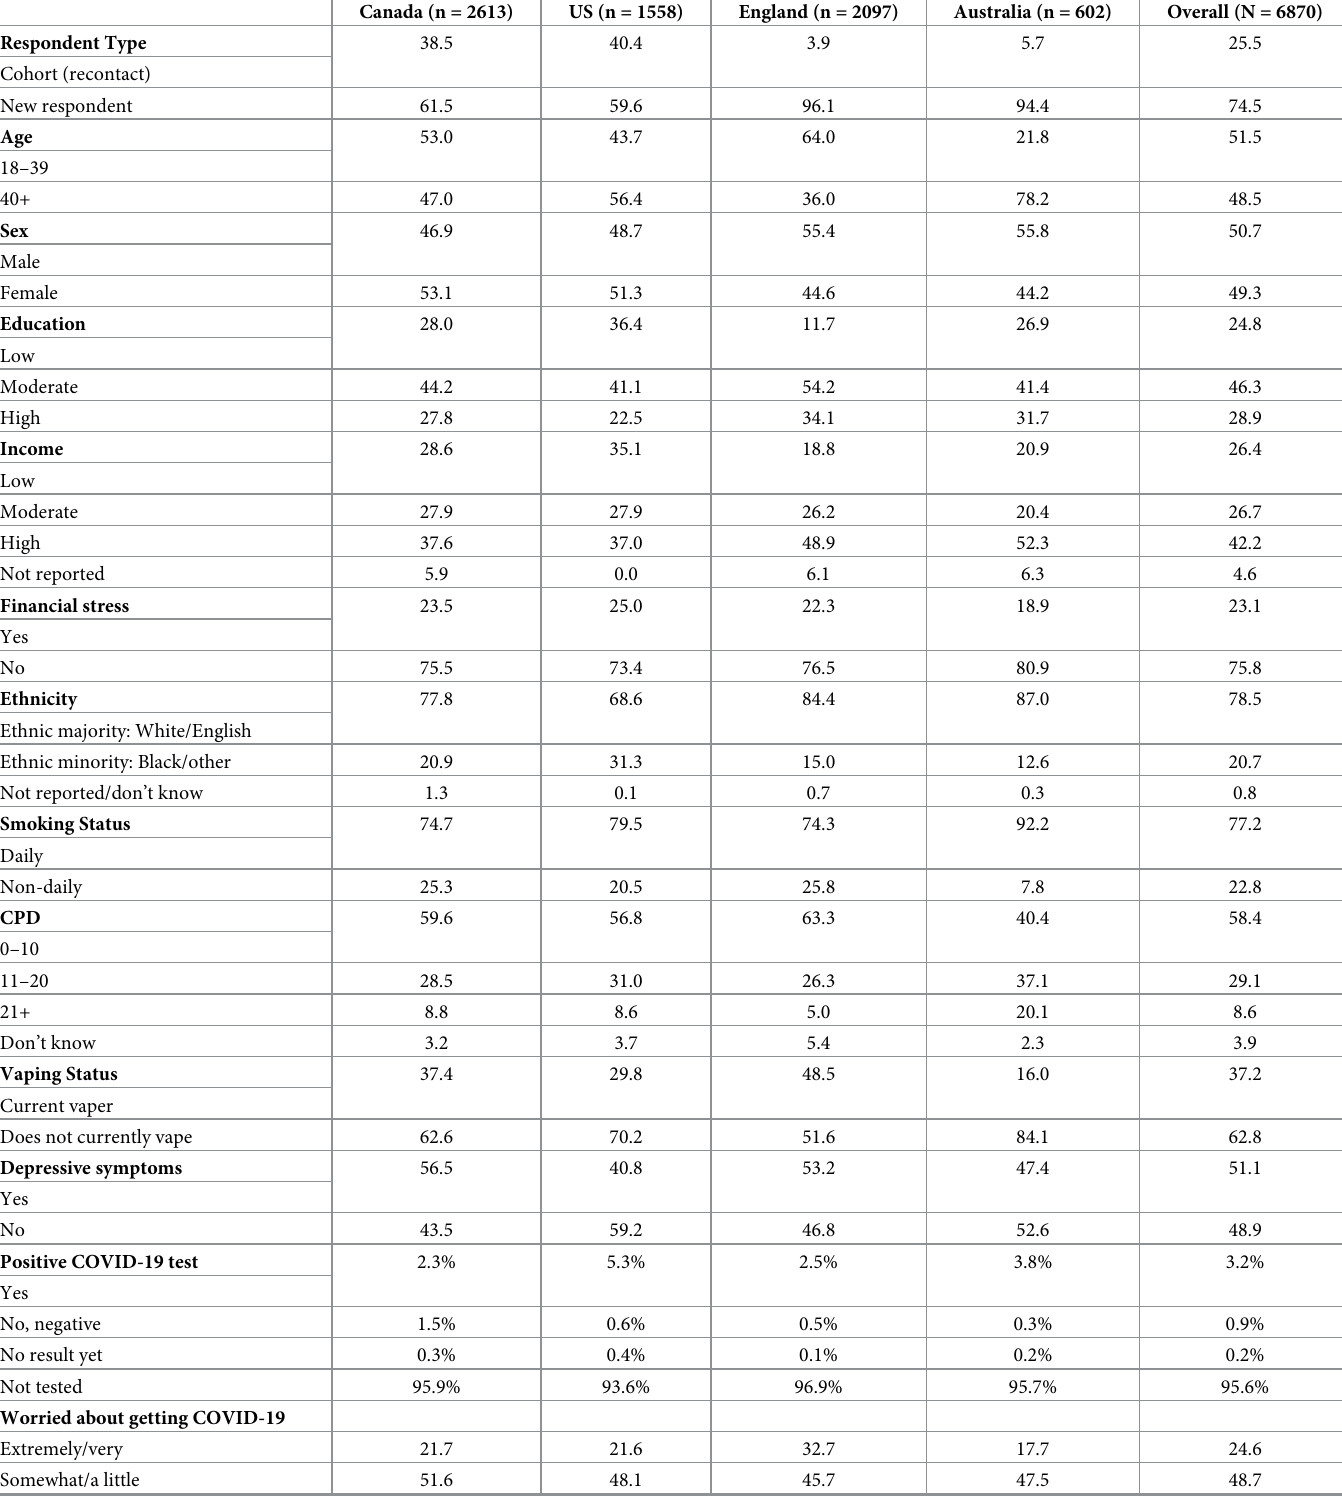
Table 1. Respondents’ sample characteristics (unweighted